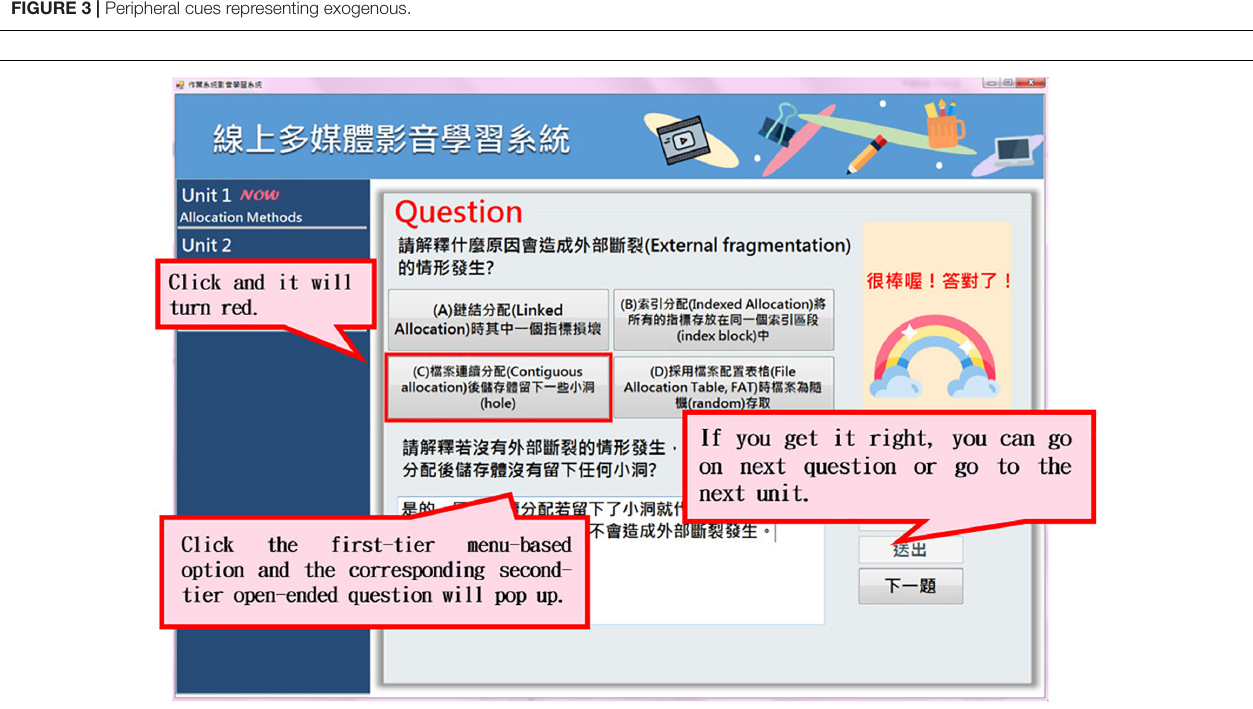
FIGURE 3 | Peripheral cues representing exogenous.